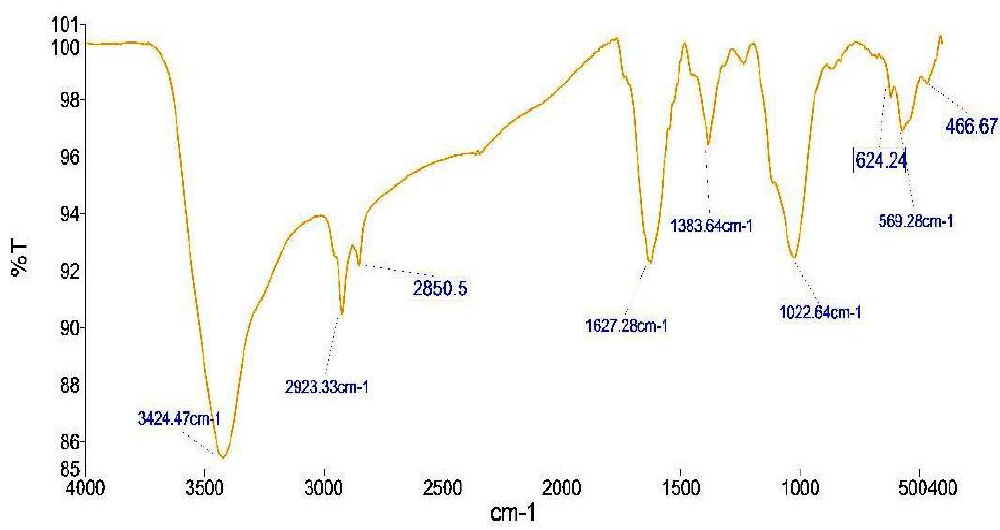
Figure 4. FTIR of biosynthesised AgNPs.